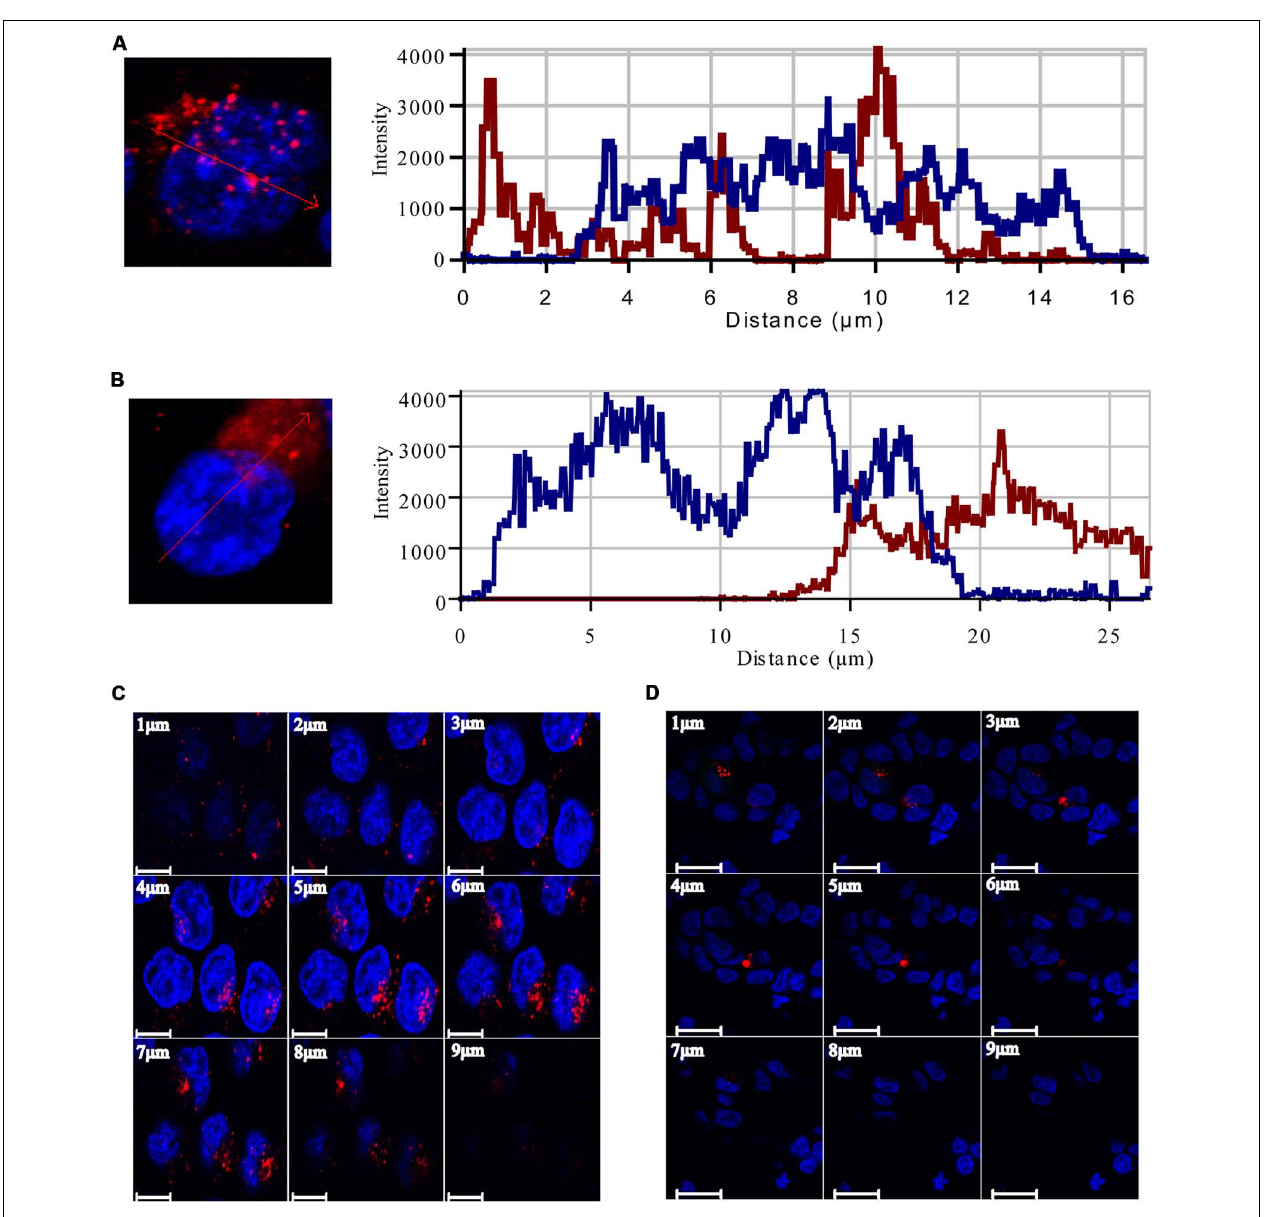
FIGURE 5 | Localization of anti-miR21 and pre-miR21. Localization of Cy3-labeled anti-miR21 (A) or Cy3-labeled pre-miR21 (B) (both red). Nucleus indicated by DAPI (blue). The corresponding line scans were taken